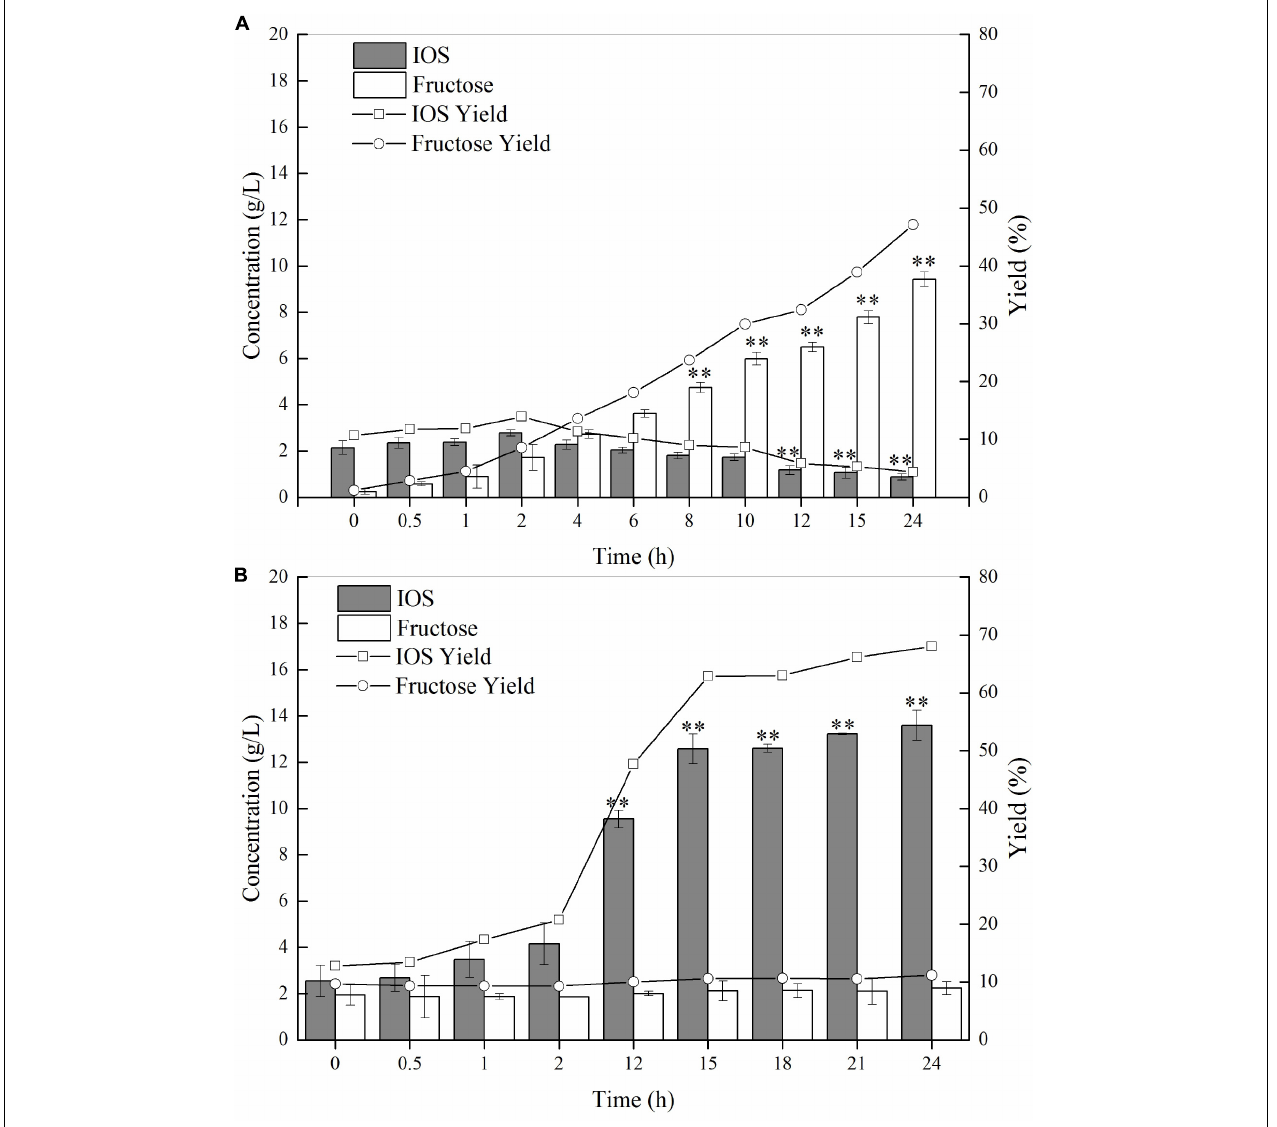
FIGURE 4 | Inulin hydrolysis by P55 (A) and P70 (B) . The conditions of 24 h-enzymatic hydrolysis were as follow: 20 g/L inulin, 10 U inulinase activity per gram of inulin, 50 ◦ C and pH 4.6. Statistical analysis was performed using a one-way ANOVA with Tukey’s test to determine a significant increase or decrease of IOS or fructose compared with those at 2 h ( p < 0.01). ∗∗ Indicates a statistical